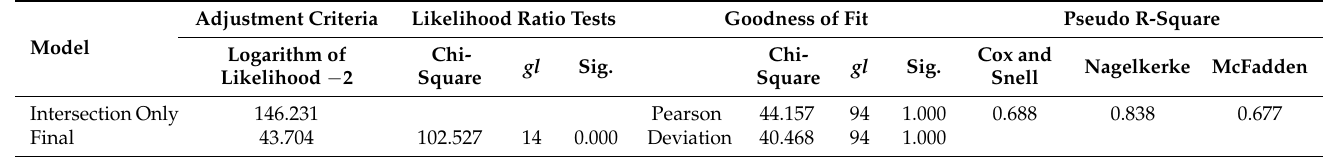
Table 2. Model Adjustment Information.